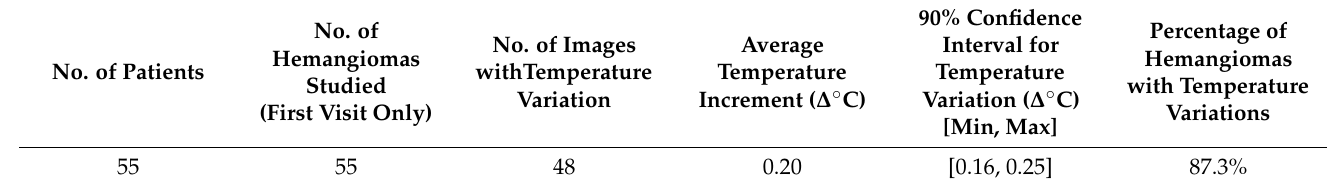
Table 1. Summary of the clinical experience analyzing infantile hemangiomas with a thermal camera (first phase of the study). Preliminary results before initiating